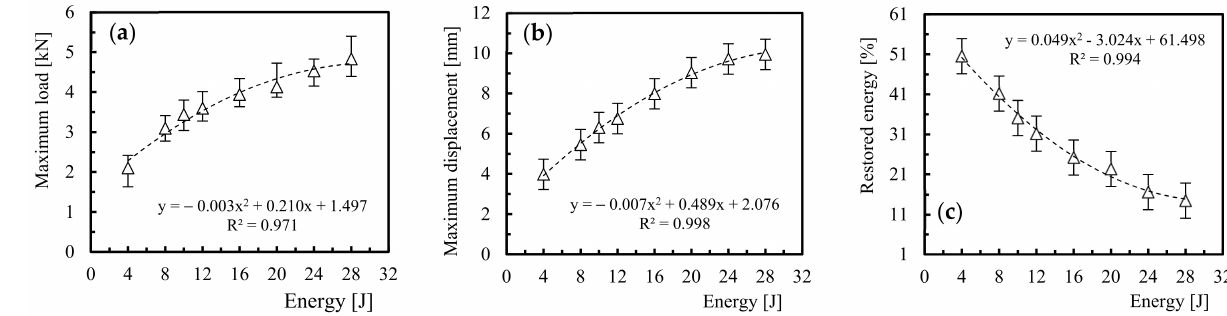
Figure 5. For different impact energies: ( a ) Maximum impact load, ( b ) Maximum displacement, ( c ) Restored